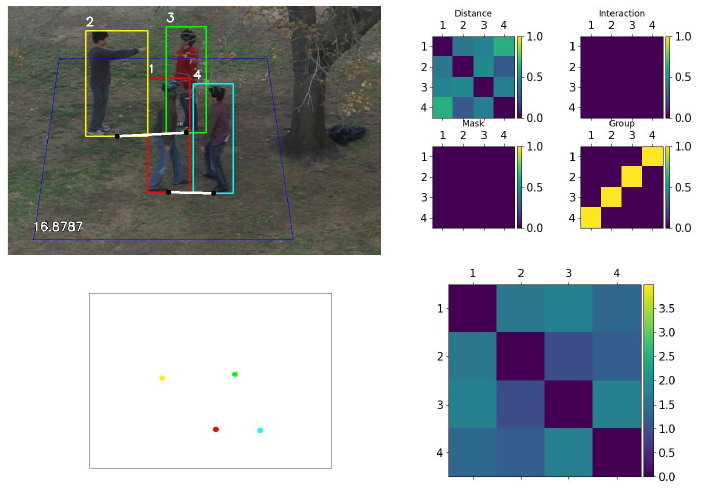
Figure 11. Full system result of UTI interaction dataset at t 2 .